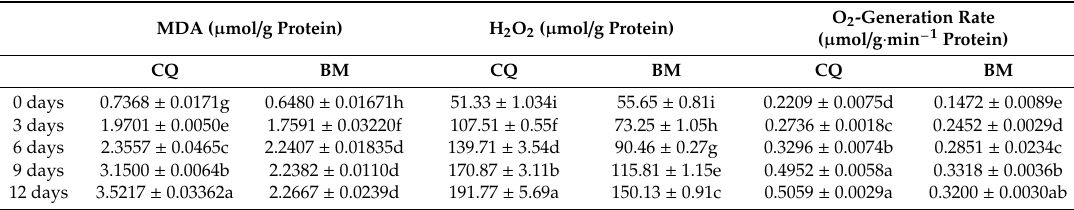
Table 2. E ff ect of Ca(NO 3 ) 2 stress on malondialdehyde (MDA), hydrogen peroxide(H 2 O 2 ), and the O 2 -generation rate in cucumber root mitochondria. The p values marked with similar letters are not significantly di ff erent (DMRT (Duncan’s multiple range test), p < 0.05). All the values are the mean of three replicates ±